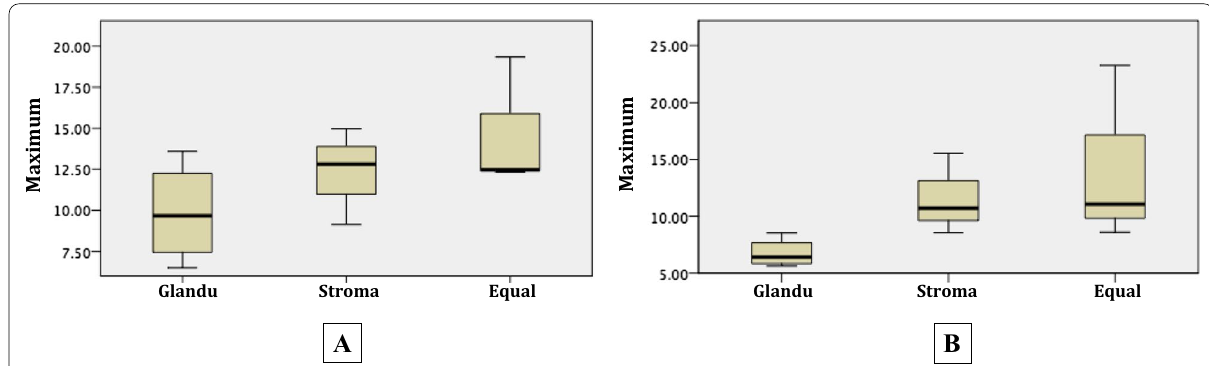
Fig. 3 Demonstrating correlation of the maximum stiffness (kPa) between each predominated proportion of BPH in A first MRE B second